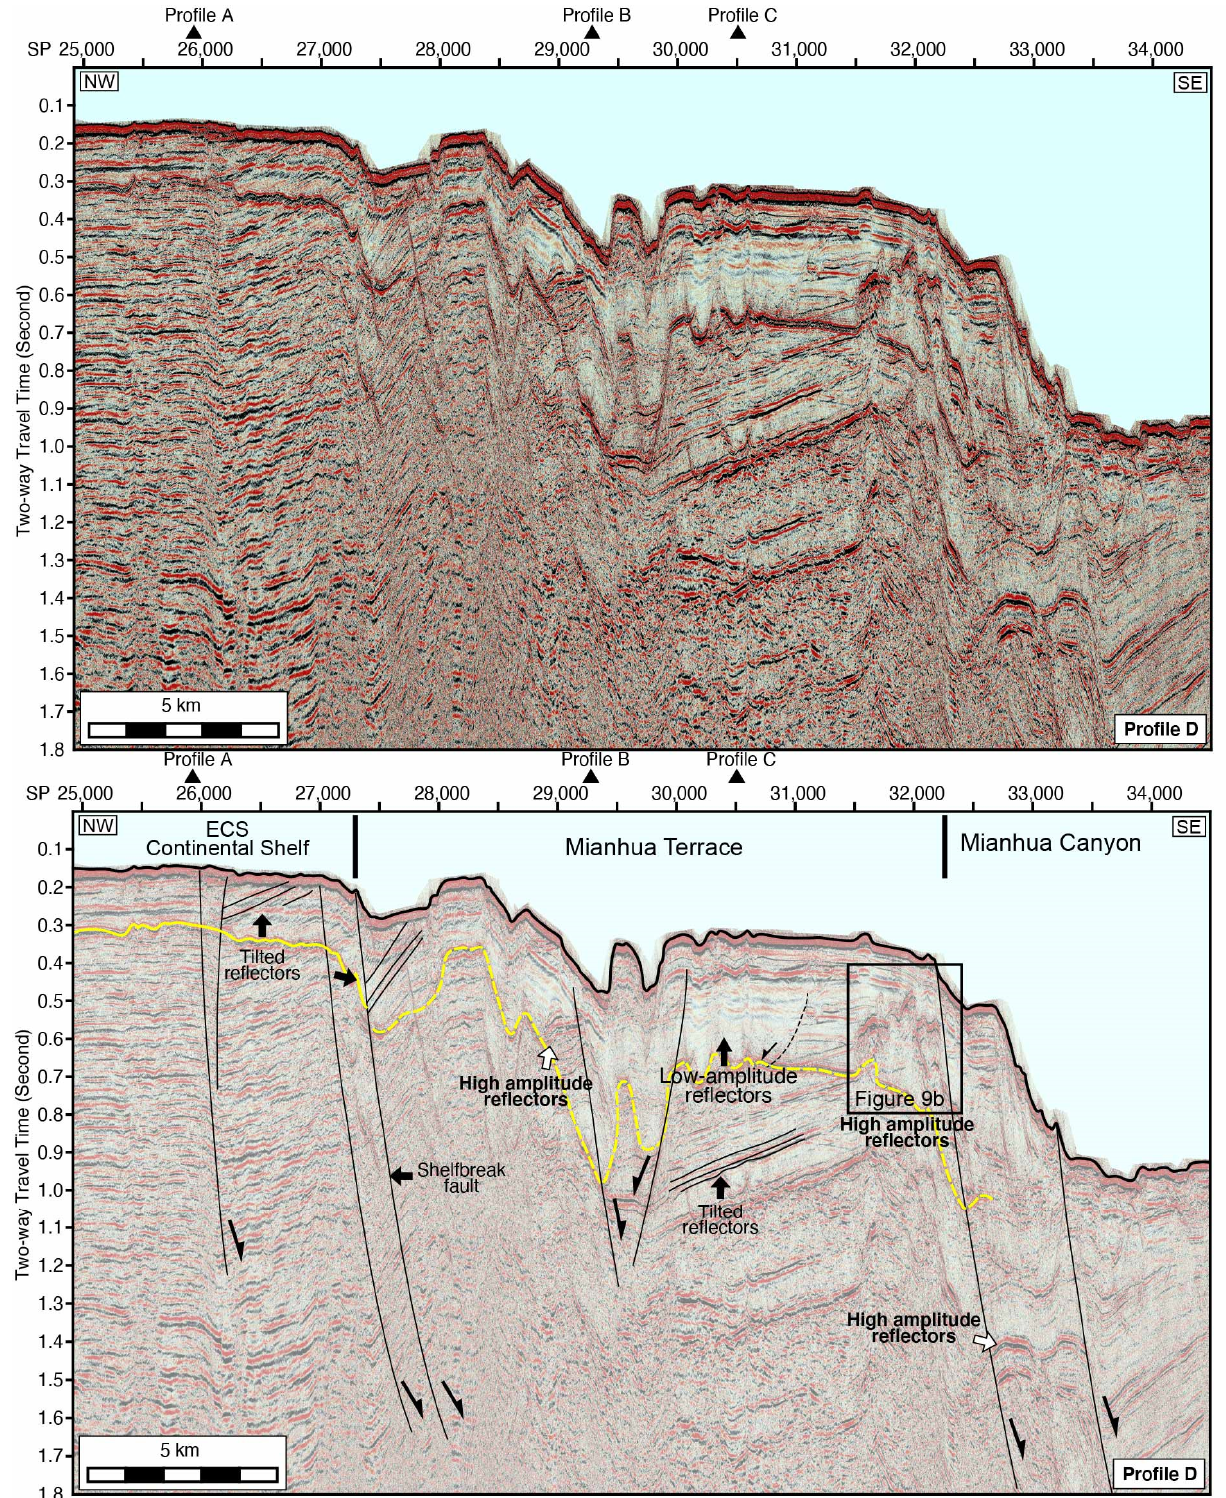
Figure 7. MCS data of Profile D across the Mianhua Terrace in the NW–SE direction. Yellow lines indicate seafloor multi- ples.